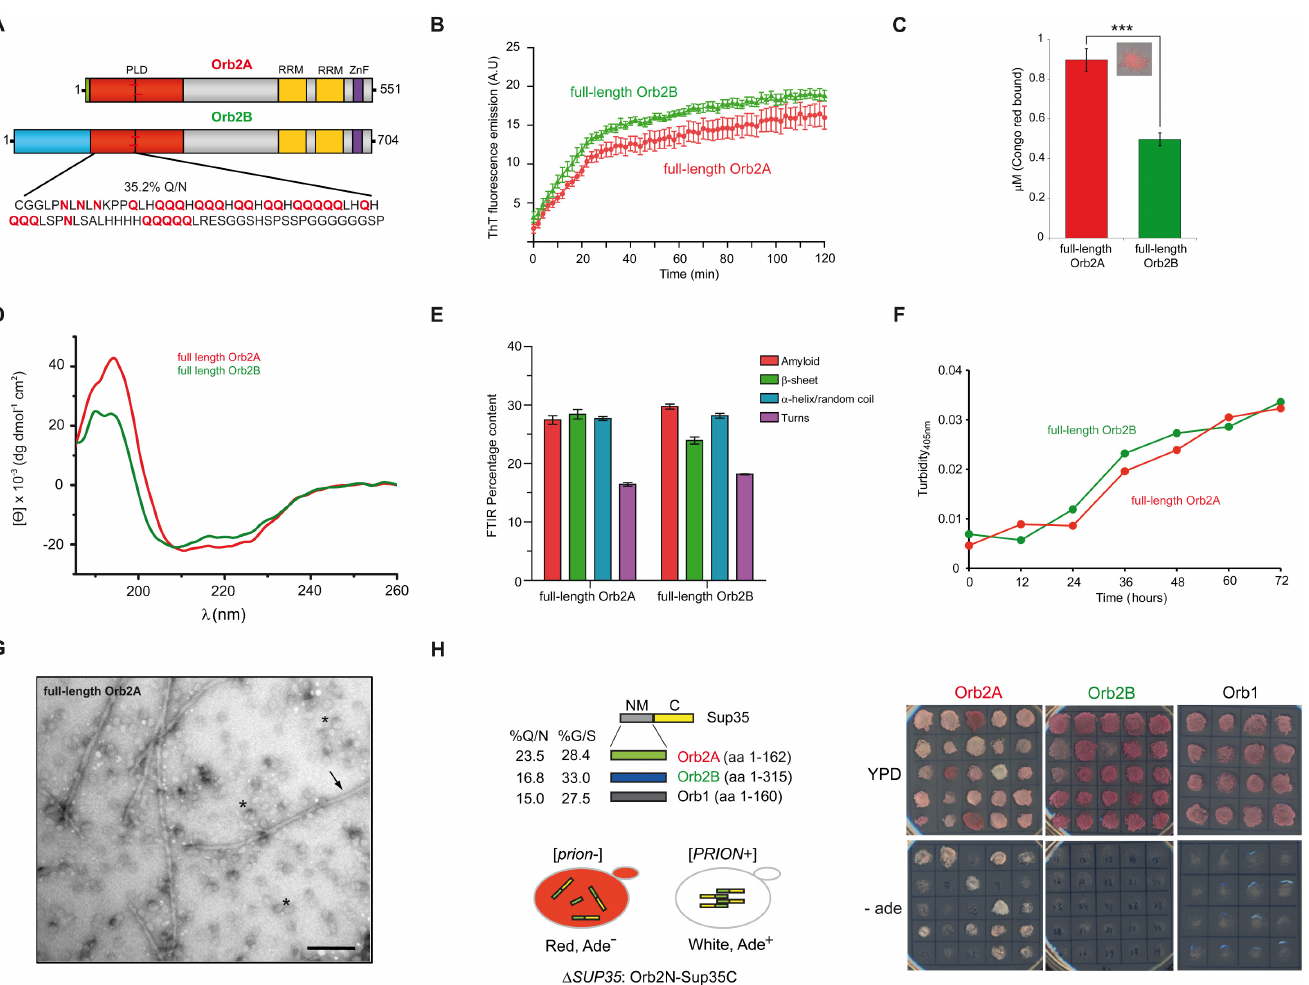
Fig 1. Orb2 forms self-propagating and canonical amyloids. (A) Pictograms showing the domain organization of Orb2A and Orb2B isoforms. PLD, prion- like domain, in red; RRM, RNA-binding domains, in yellow; ZnF, zinc-finger motif, in purple. The N-terminal amino acids preceding the PLD of Orb2A (eight amino acids) and Orb2B (162 amino acids) are represented in green and blue, respectively. (B) In the presence of both Orb2A and Orb2B, ThT (Proteostat) shows enhanced fluorescence emission at 485 nm over time, a typical feature of amyloids, although the kinetics is much faster for Orb2A and Orb2B than other amyloids (see S1 Fig). (C) Concentration ( μ M) of the azo-dye CR bound to the amyloid component formed by Orb2. The data are represented as the mean ± standard error of the mean (SEM): *** p < 0.001 (One-way ANOVA and Tukey post-test). The inset shows a 63x image of an Orb2A amyloid under a polarized light microscope. (D) The CD spectra of soluble, full-length isoforms of Orb2 showed a α -helix-rich secondary structure. Deconvolution of the CD spectrum by using algorithms in DICHROWEB showed that Orb2A has 6% more α -helix and 5% less random coil conformations than Orb2B. (E) Relative abundance of secondary structural elements determined using FTIR. These distributions are significantly different from one another and from a non- amyloidogenic control protein concanavalin A control with a p -value of < 0.001 (chi-square test). (F) Aggregation of both isoforms over the incubation period monitored by turbidimetry at 405 nm. (G) Representative electron micrograph of oligomers (asterisks) and amyloid fibers (arrow) formed by Orb2A. Scale bar: 0.2 μ m. (H) Schematic representation of the constructs used in the yeast prion assay (left panel). Orb2A-Sup35C efficiently switches to the prion state. Randomly selected clones were replica plated either in complete yeast extract peptone dextrose (YPD) media or in media lacking adenine. Only Orb2A produced a high frequency of red Ade - and white Ade + colonies (right panel). NM: N-terminal and medial regions; C: C-terminal region. The underlying data for panels in this figure can be found in S1